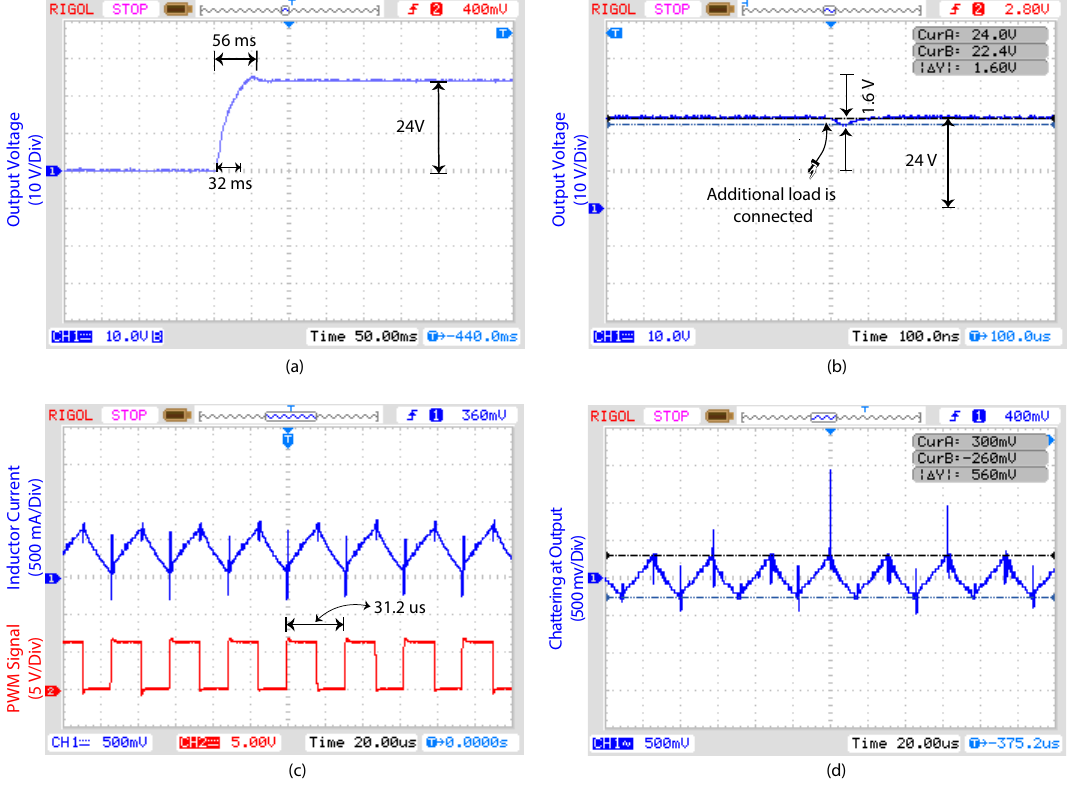
Figure 4. Experimental waveforms of the closed loop system with FEEC-SMC. ( a ) Step response of the closed loop system. ( b ) Output voltage when load is shifted from 82 Ω to 29.88 Ω indicating robustness of the closed loop system. ( c ) Inductor current and gating signal at output of LM311 during steady state operation. ( d ) Chattering in the output